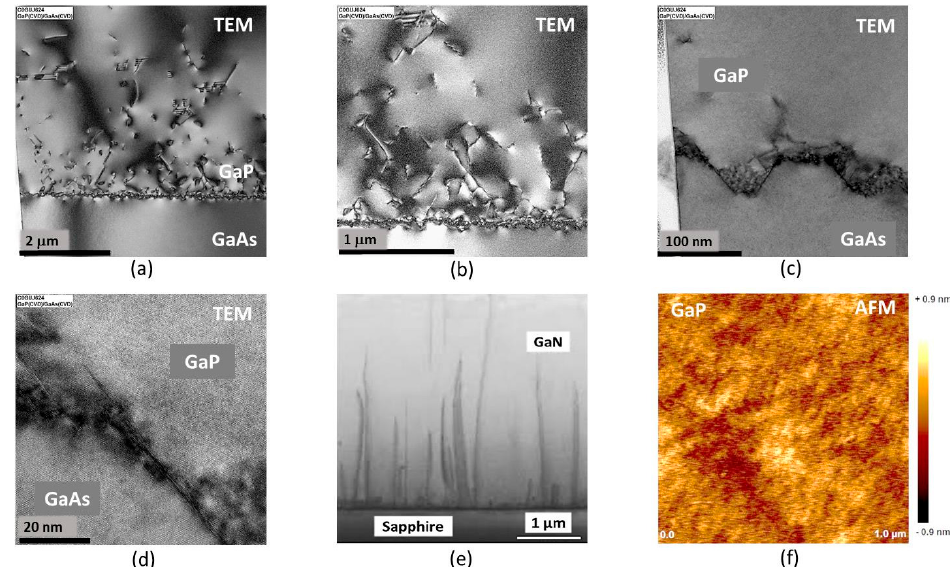
Figure 37. ( a – d ) TEM cross section images with different magnification in the area near to the GaP/GaAs interface; ( e ) a cross section image of a thick HVPE grown GaN layer that shows a reduction of the dislocation density with layer thickness [96]. (Reproduced from [96] with the permission of AIP Publishing); ( f ) top surface of thick HVPE grown GaP on GaAs substrate showing smooth surface morphology.